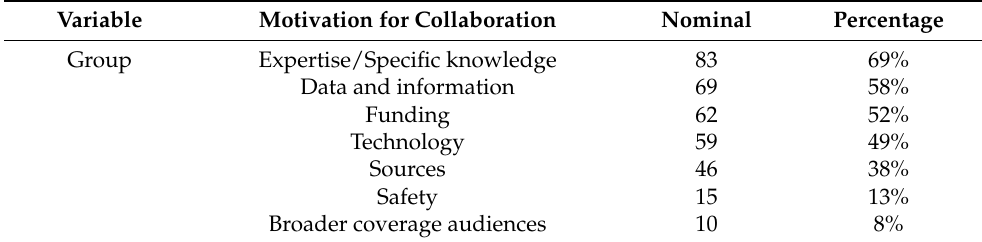
Table 17. Motivation for